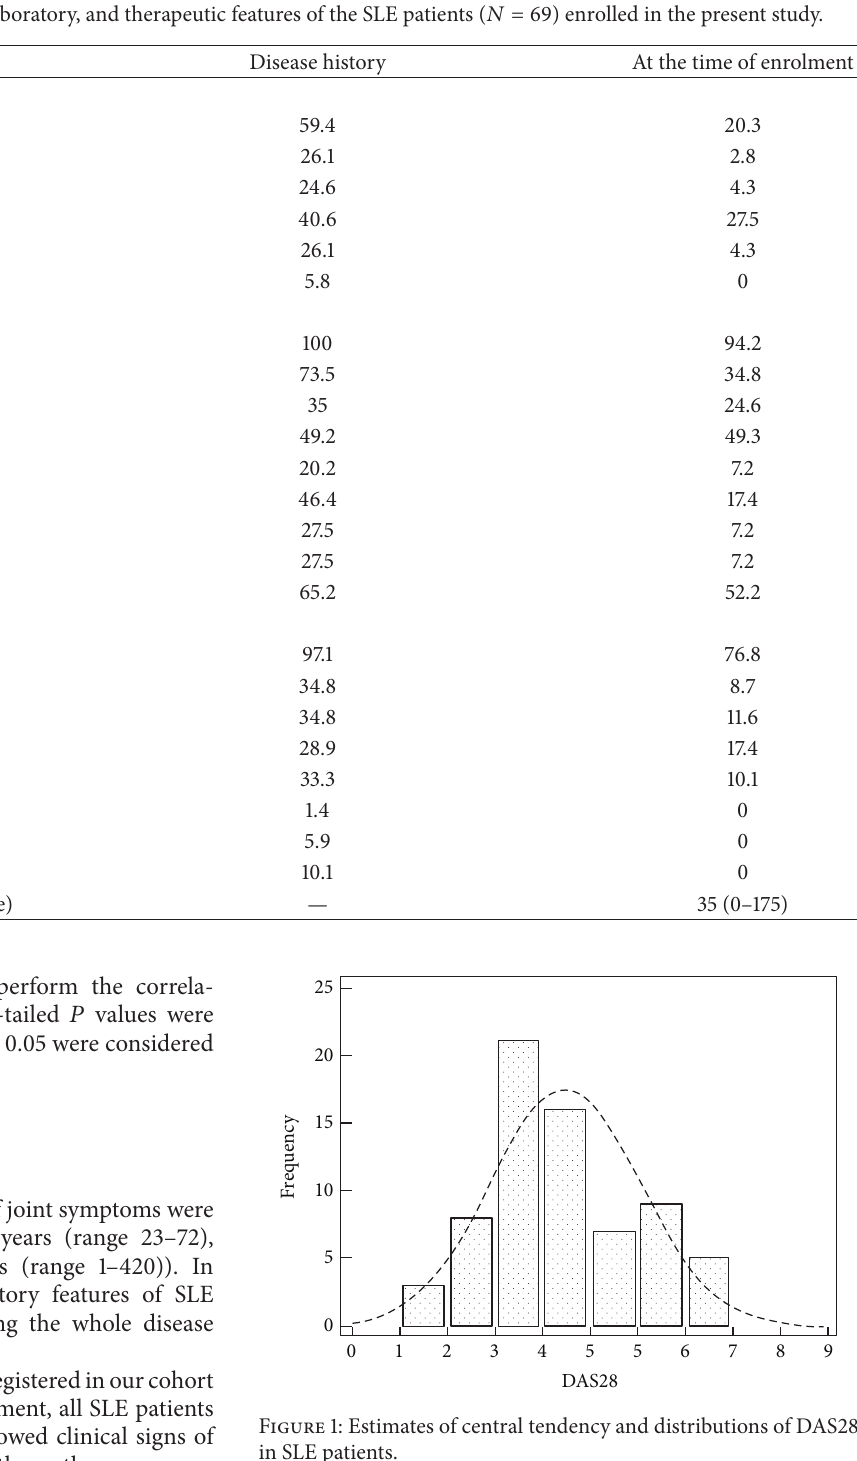
(26.1%) high disease activity; moreover 8 SLE patients